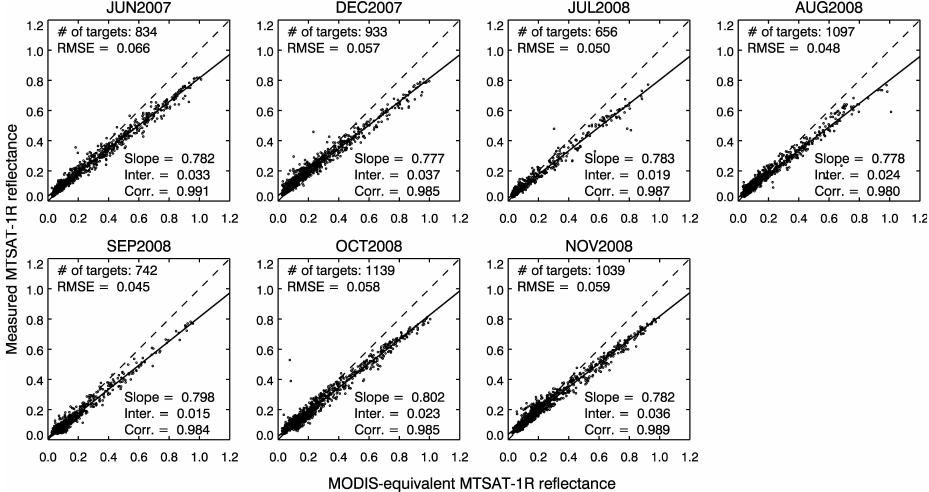
Fig. 11. Same as in Fig. 7 but for the MTSAT-1R 0.724-µm channel (Method